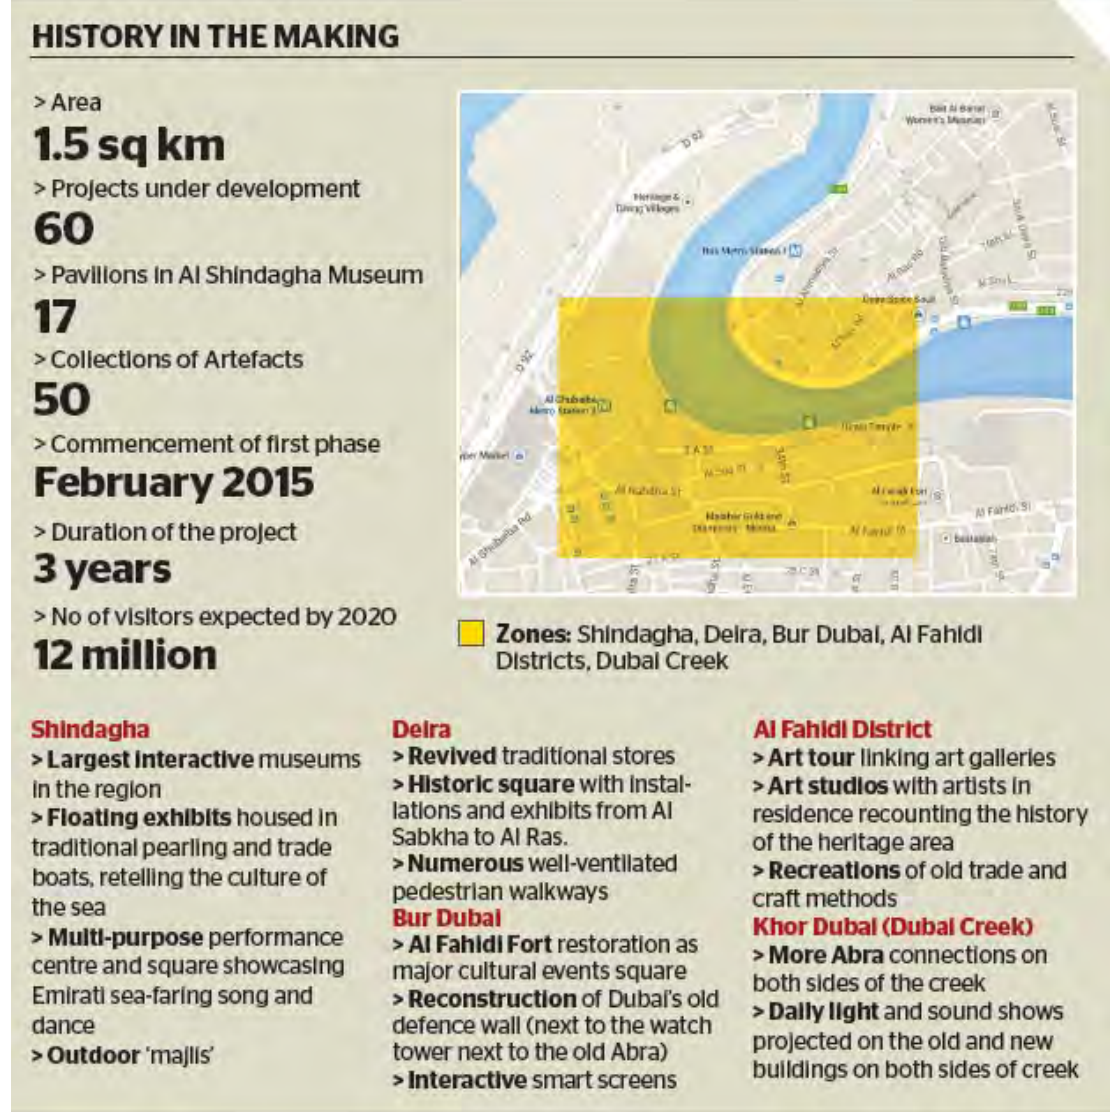
Figure 1. Develop Dubai Historical District project (Khaleej times,